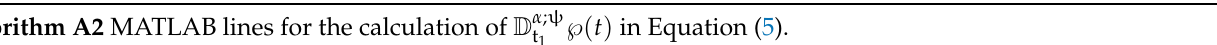
Algorithm A2 MATLAB lines for the calculation of D α ; ψ